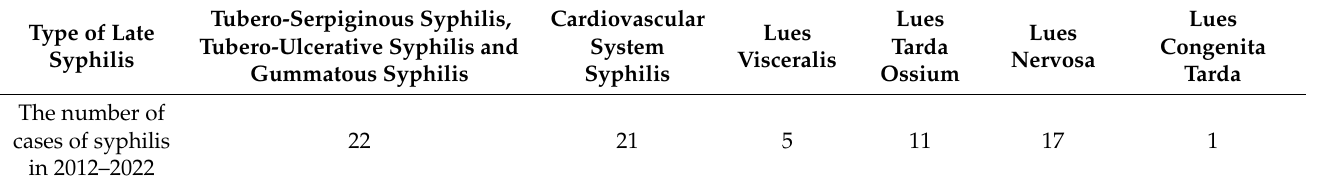
Table 1. Number of case reports of tertiary syphilis based on the PubMed database from the last 10